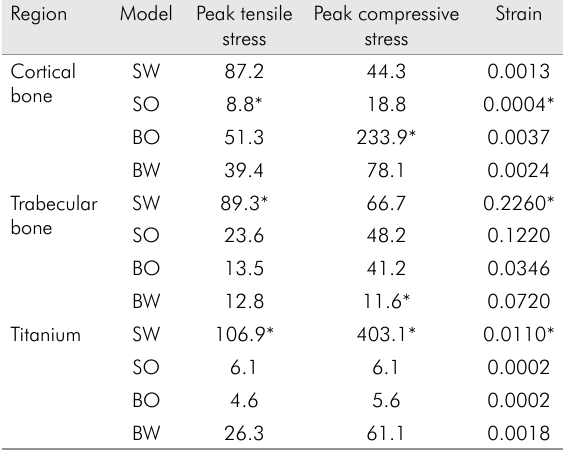
Table 2. Peak tensile and compressive stresses (MPa) and maximum strain (µm) in the crestal cortical, trabecular, and api- cal cortical bone measured under centric loading